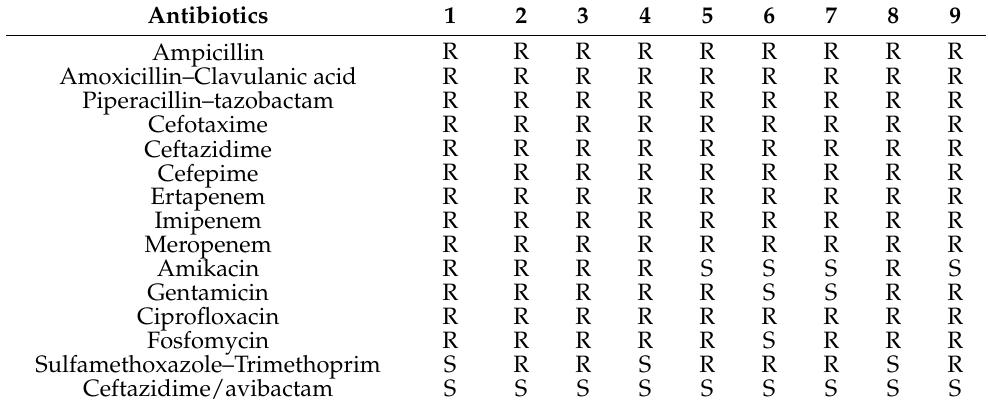
Table 3. CRPK resistance